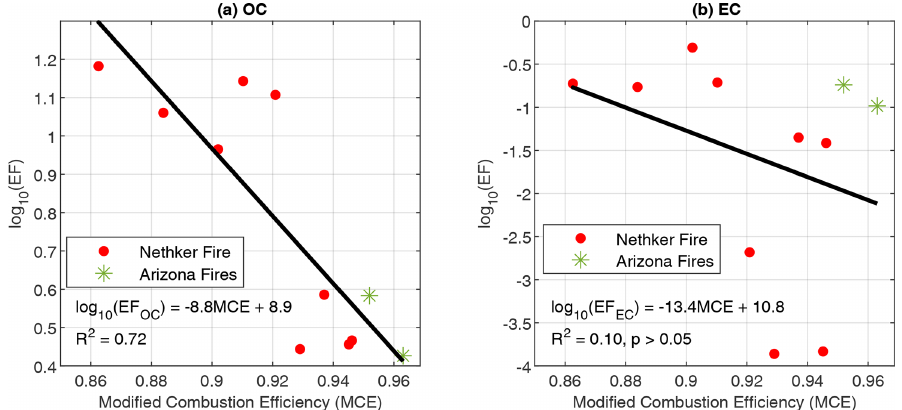
Figure 2. (a) Emission factors of OC as a function of modified combustion efficiency (MCE) and (b) EC vs. MCE. Colors indicate the different fires. Black lines indicate the linear fits. Data points from the 204 Cow Fire did not meet the criteria to be used for EF calculations.